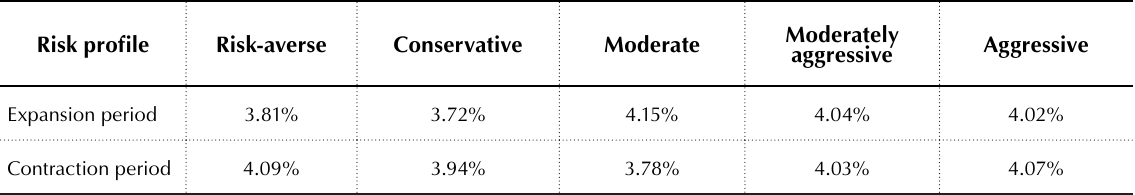
Table 1. Composition of high-yield bonds in an investor’s optimal portfolio Risk